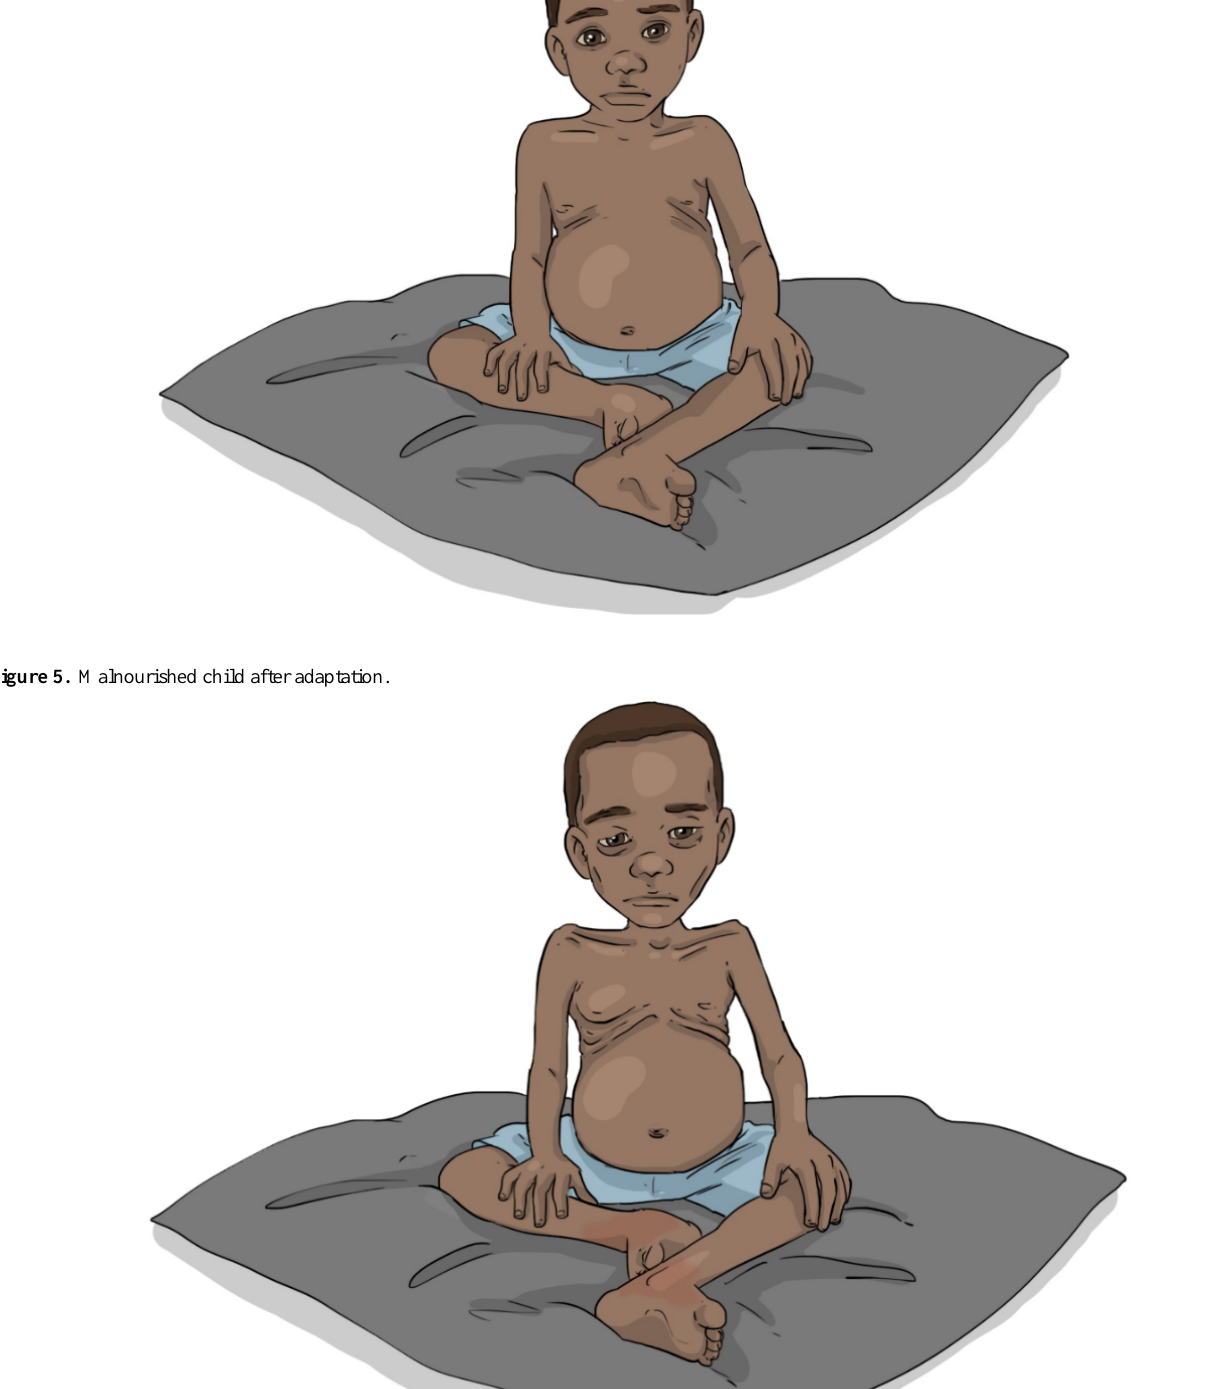
proficiency. For a comprehensive list of health worker–related factors and how they were incorporated into this process,